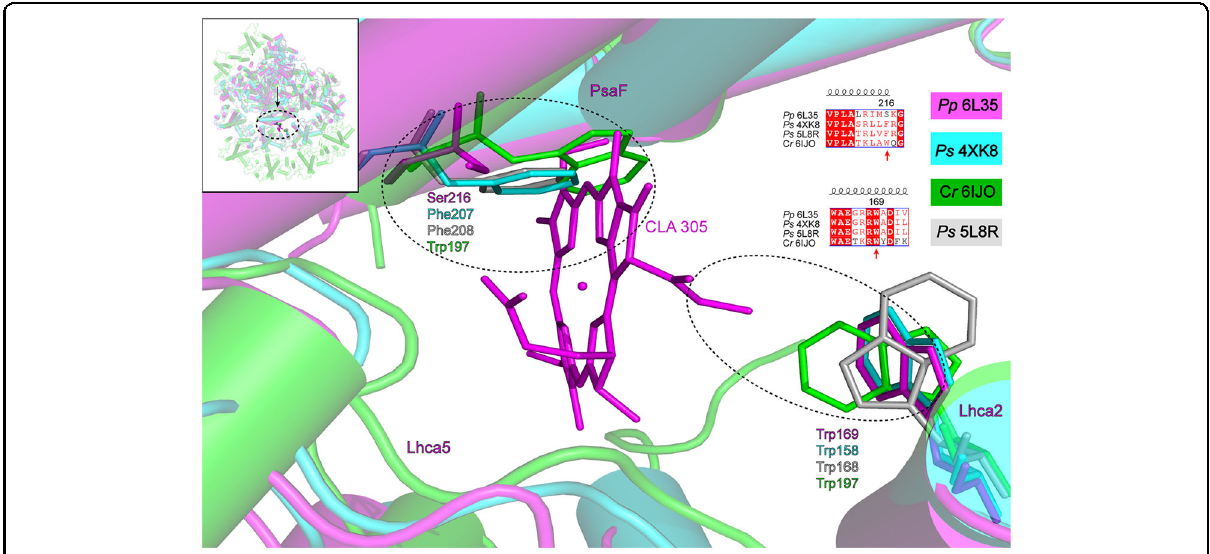
Fig. 2 Structural comparison of PsaF among P . patens , P . sativum , and C . reinhardtii . CLA 305 clamped by PsaF, Lhca5, and Lhca2 in P . patens are shown as lines and labeled. The surrounding amino acid residues of Ser 216 and Trp 169 and corresponding residues in P . sativum and C . reinhardtii are shown and labeled. Color codes and PDB ID codes: P . patens , purple, 6L35; C . reinhardtii , green, 6IJO; P . sativum , cyan and gray, 4XK8 and 5L8R,